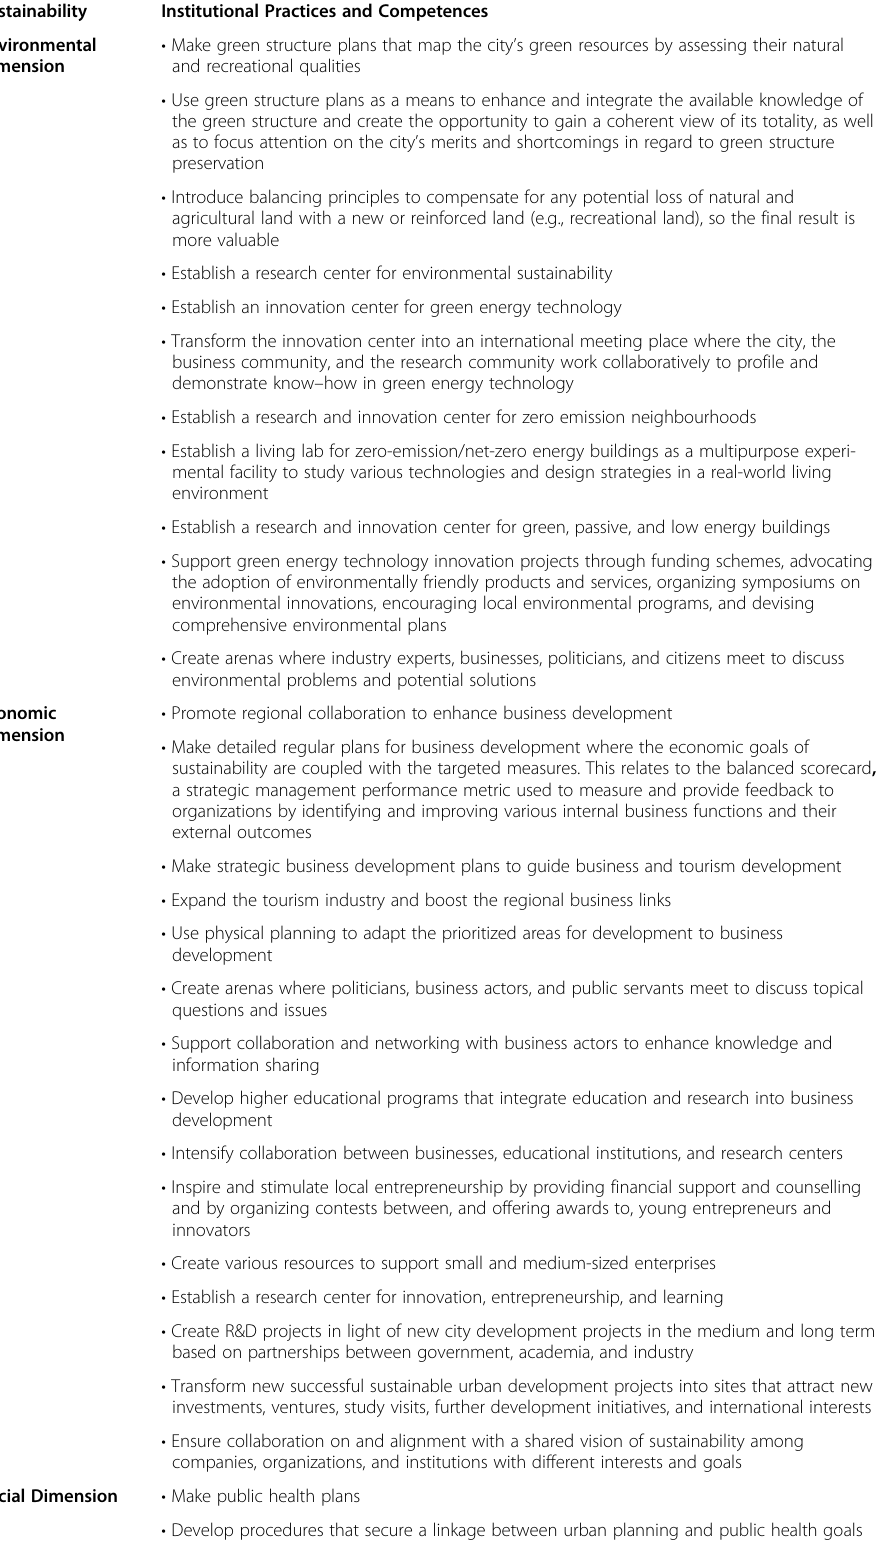
Table 7 The core institutional practices for supporting the balancing of the three dimensions of